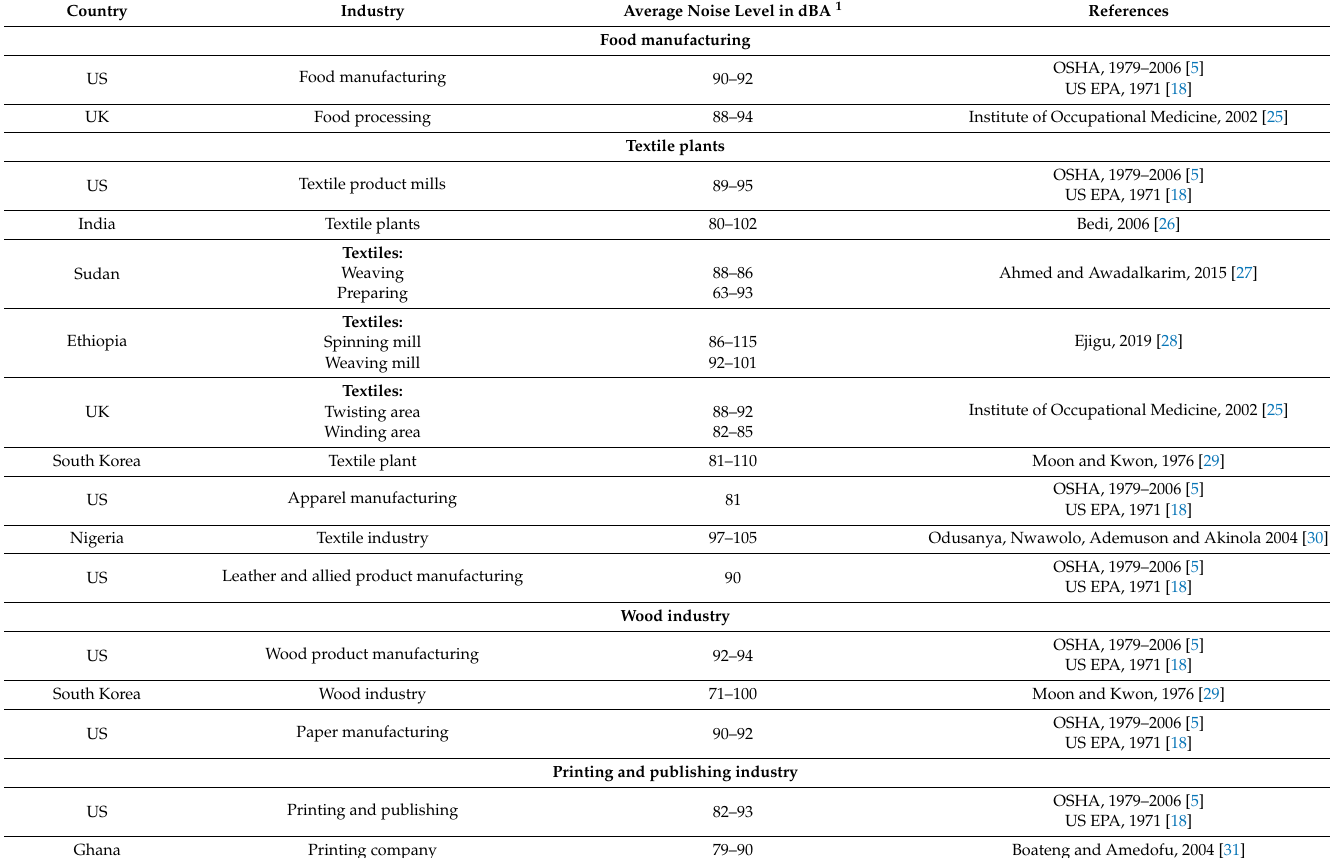
Table 1. Average noise levels per manufacturing industry